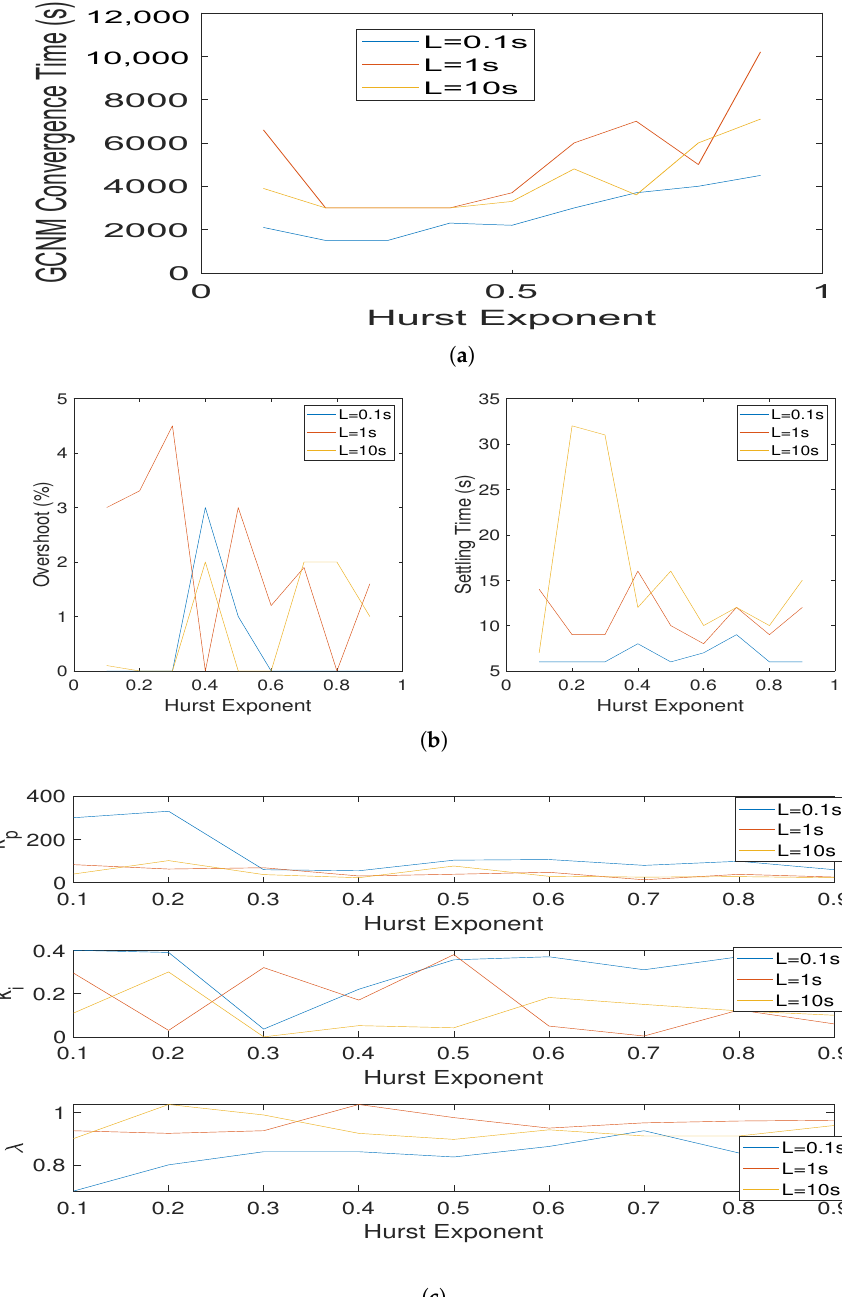
Figure 9. SOC controller: ( a ) overall convergence time, ( b ) overshoot and settling time, and ( c ) final PI gains after 50 iterations for L =